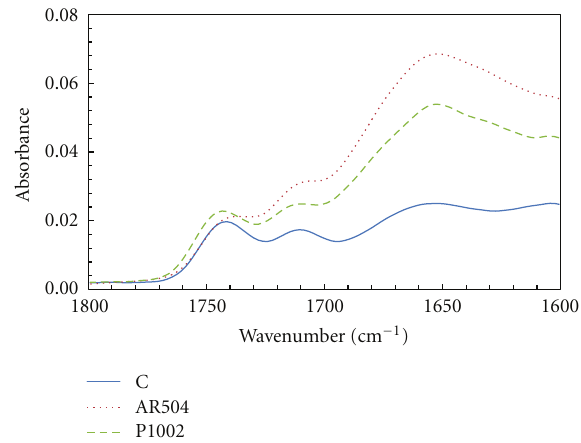
Figure 7: Infrared absorbance of sunflowerhull/PP blends. Ab- sorbance in 1600 cm − 1 to 1800 cm − 1 range is indicative of the carbonyl functional